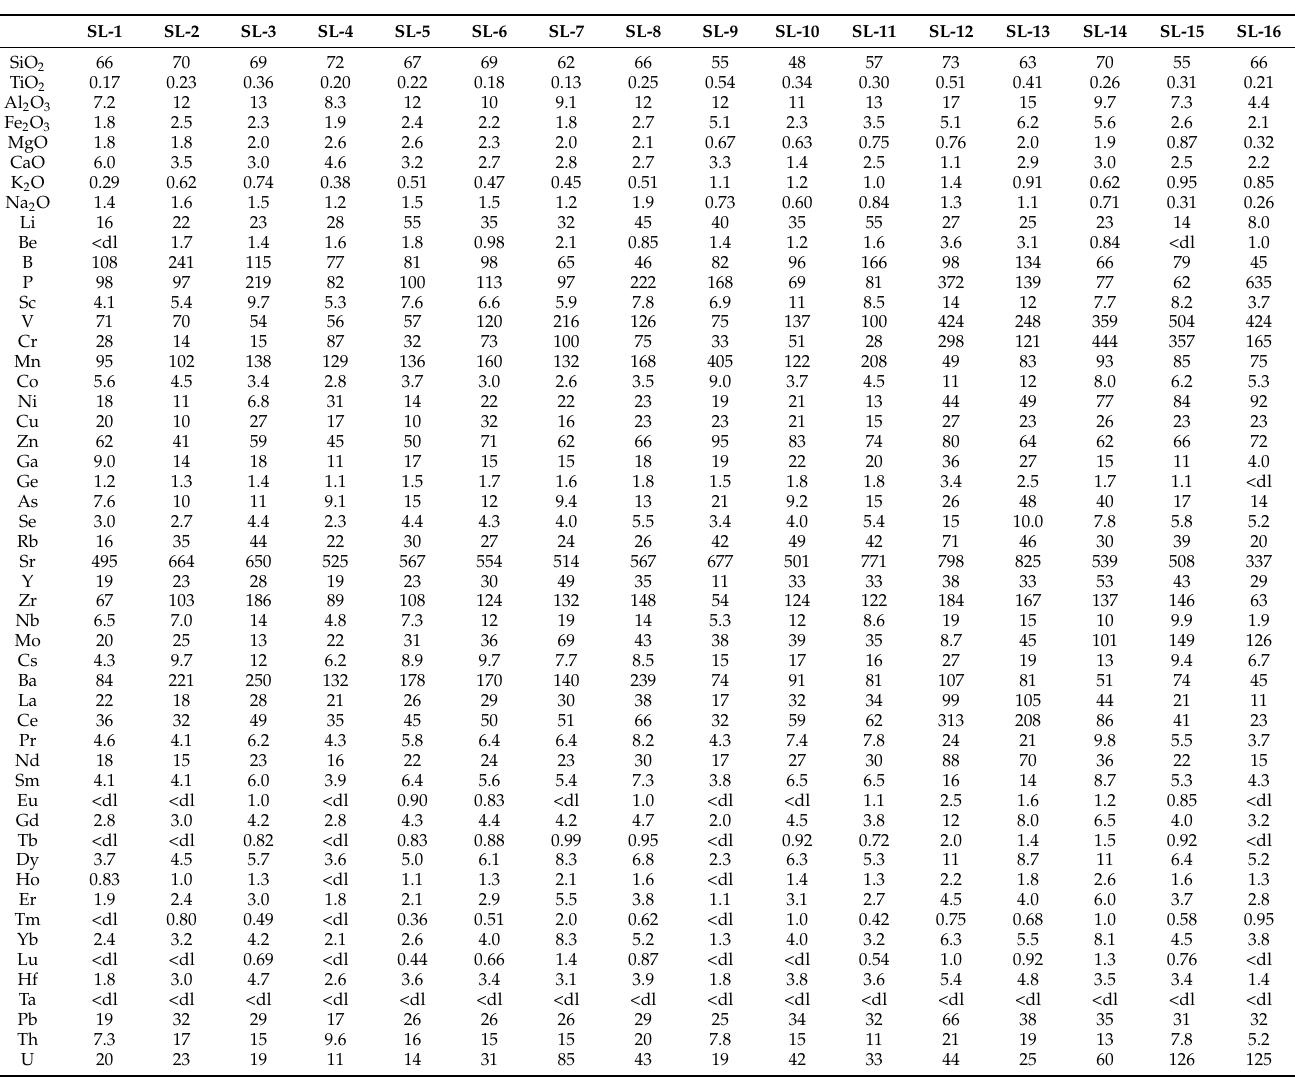
Table 3. Major-element oxides (wt%) and trace element concentrations ( µ g/g) of the samples from borehole SL-1 (on whole-coal